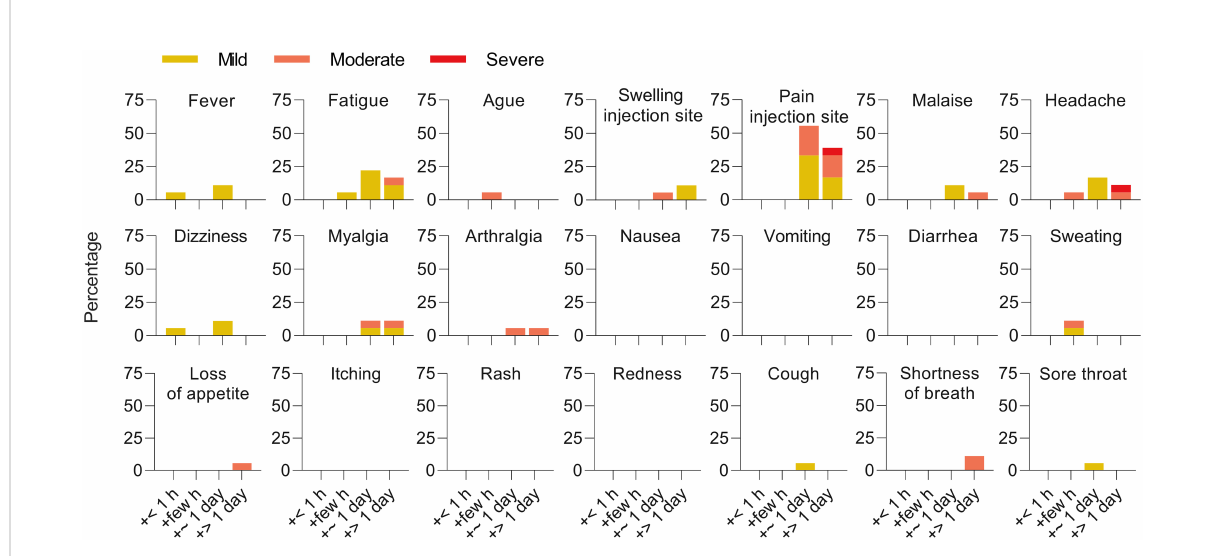
FIGURE 1 Reactogenicity of a ‘ booster ’ after heterologous primary vaccination. Solicited adverse reactions following BNT162b2 ‘ booster ’ vaccination. Percentages of n = 18 participants with individual symptoms following vaccination are shown. Severity is graded on a scale of 1 – 2 (for some symptoms) or 1 – 3 (for most), as adapted from the Common Terminology Criteria for Adverse Events (US Department of Health and Human Services, Version